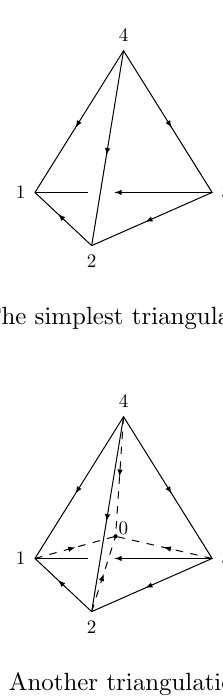
Figure 7. Another triangulation of a